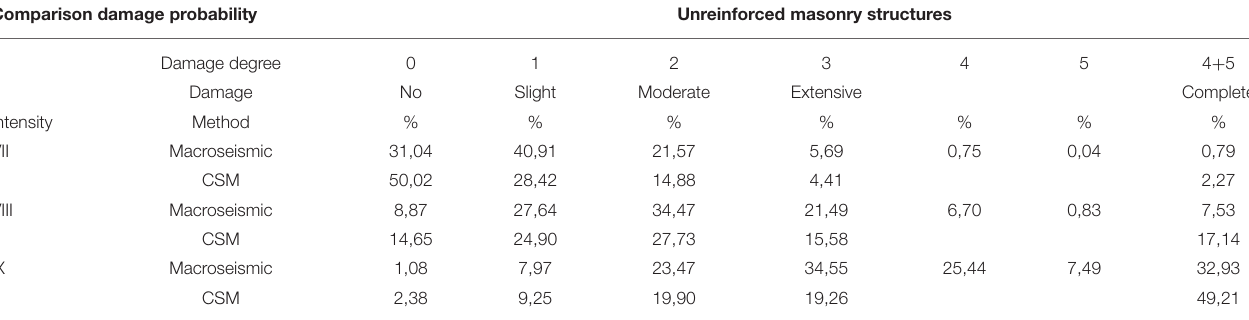
TABLE 5 | Comparison of estimated damage probabilities. Comparison damage